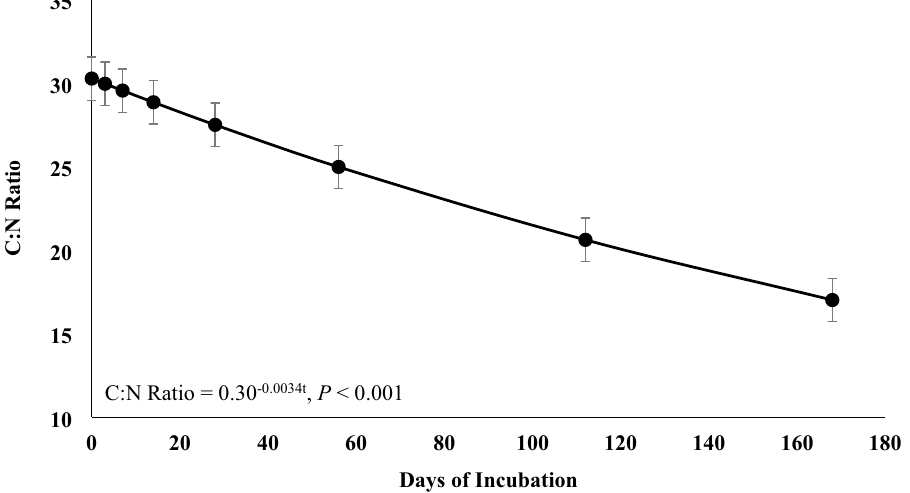
Figure 2. Carbon-to-nitrogen ratio of rhizoma peanut roots and rhizomes during a 168-days incubation period. The values represent the averages of two treatments (grazed and non-grazed) and 2 years. Bars refer to the SE.